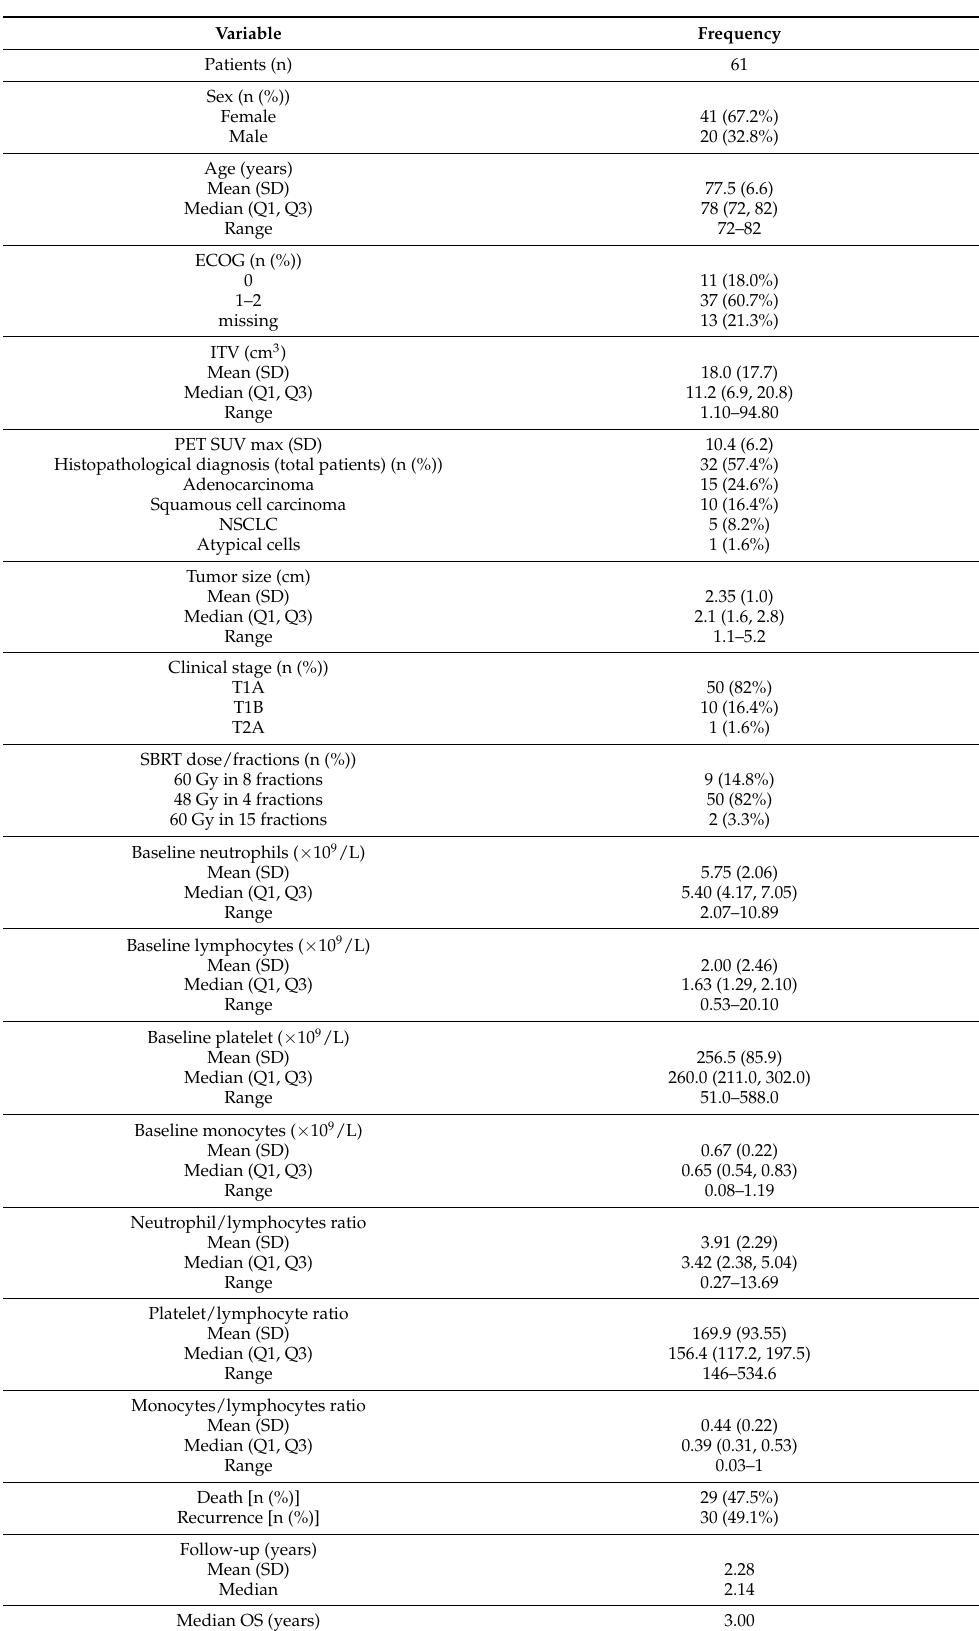
Table 1. Patient demographic and